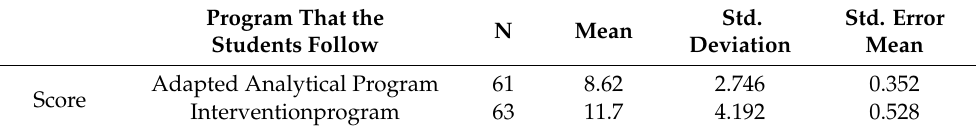
Table 8. Comparison